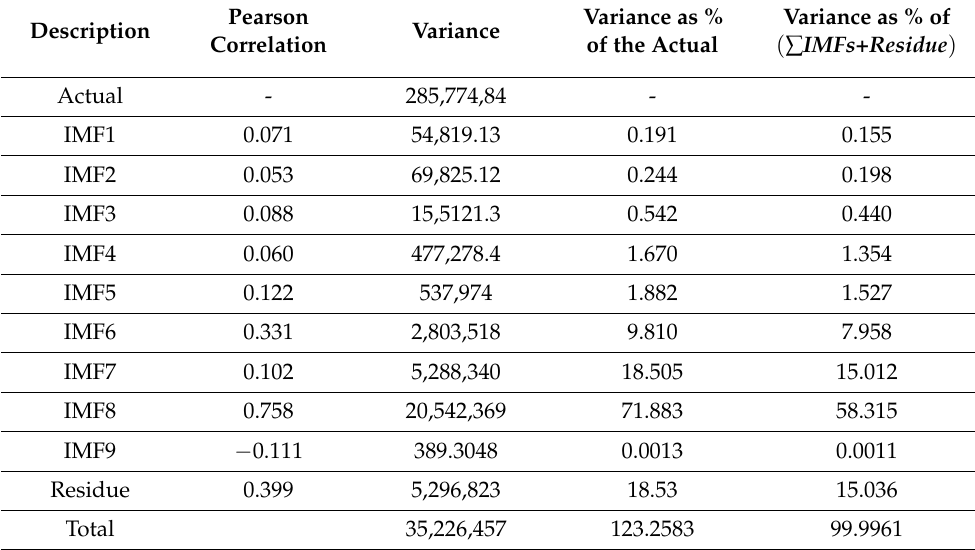
Table 3. Statistical measures of IMFs and residue extracted by implementing